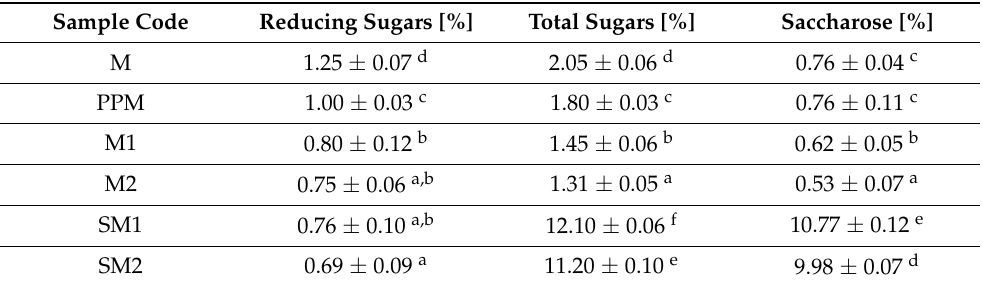
Table 5. Changes in the total sugars content, reducing sugars during fermentation and frozen desserts manufacture (cultivar “ Miranda ” of the Cucurbita moschata